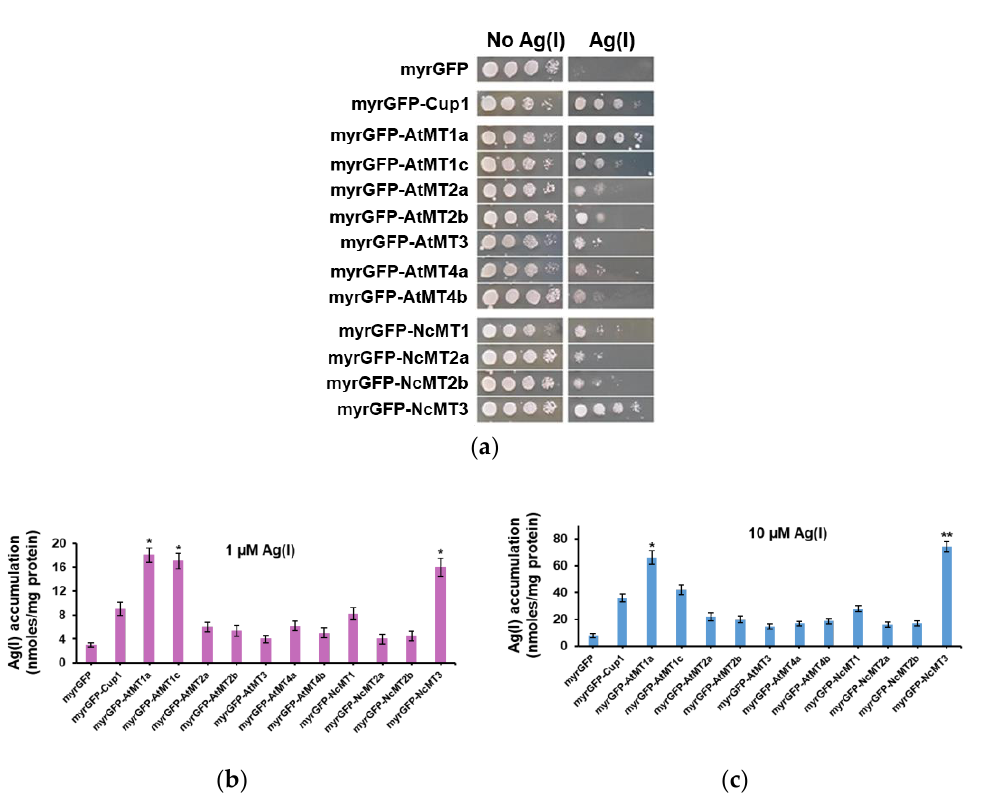
Figure 3. Ag(I)-related phenotype of yeast cells expressing plant MTs. The cup2Δ cells transformed with URA3 -based plasmids harboring myrGFP-MT under the control of GAL1 promoter were pregrown in SRaf-Ura then shifted to galactose-containing media for transgene induction. ( a ) Growth on solid medium containing Ag(I). Cells pregrown in SGal-Ura were 10-fold serially diluted and stamped on SGal-Ura/agar containing or not 100 μM AgNO 3 . Plates were photographed after 3 days’ incubation at 30 °C. ( b , c ) Ag(I) accumulation by cup2Δ cells expressing myrGFP-MTs. Transformed cells pregrown in MM/Raf-Ura were shifted to MMLC/Gal-Ura for transgene induction and incubated for 6 h (30 °C, 200 rpm) before Ag(I) was added at 1 μM ( b ), and 10 μM ( c ), final concentrations. Cells were further incubated with Ag(I) for 2 h before being harvested for metal assay. Asterisks indicate that the mean of the Ag(I) accumulation by a given myrGFP-MT strain is significantly different from the mean of the Ag(I) accumulation by myrGFP-Cup1 under the same conditions, according to one sample t test. * p < 0.05; ** p < 0.01.